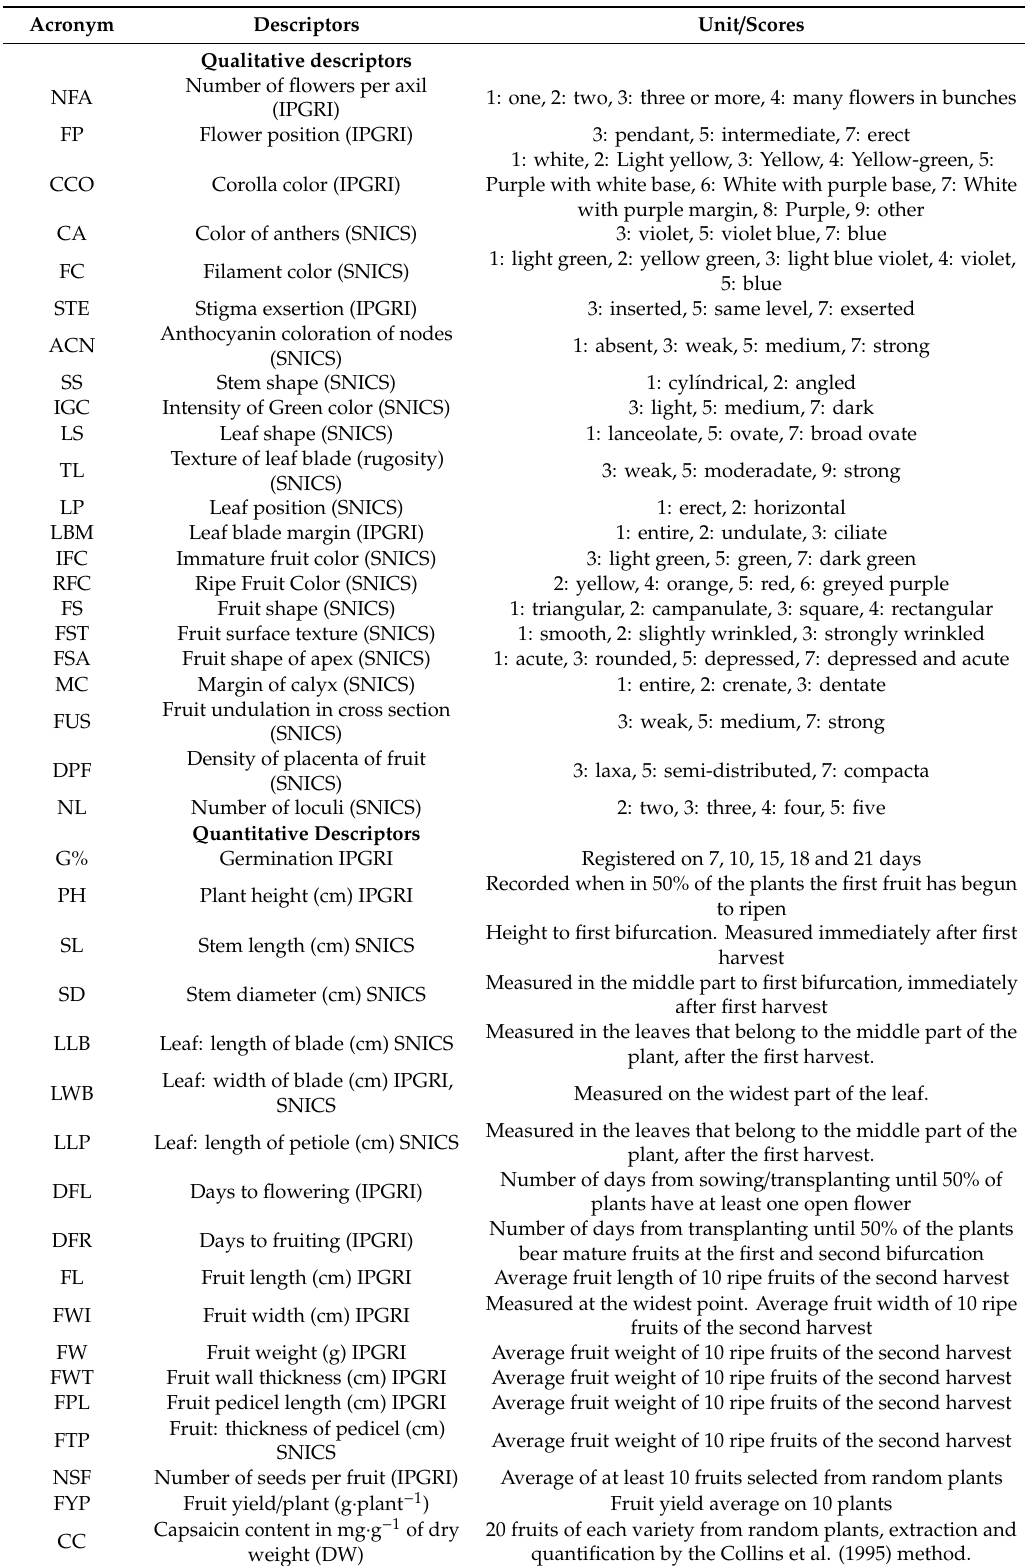
Table 1. Qualitative and quantitative traits used to evaluate F1 lines and progenitors of habanero peppers, according to the IPGRI Manual (1995) and the SNICS Manual